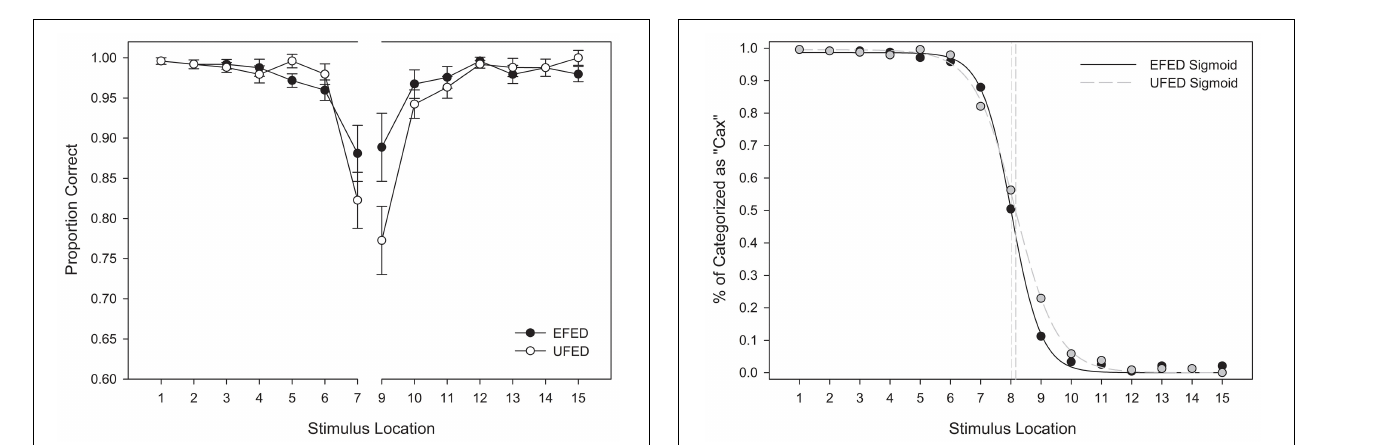
Category response frequencies